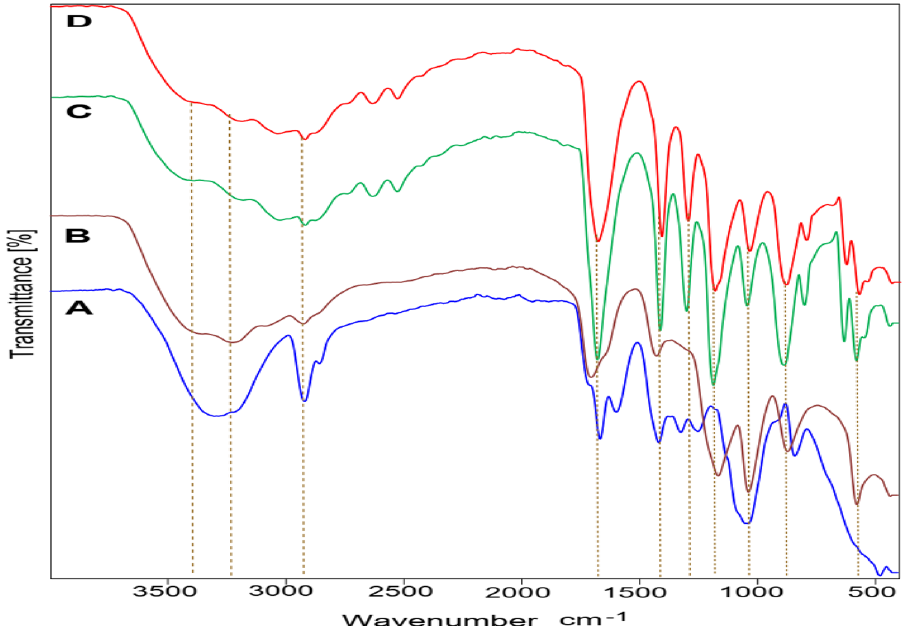
Figure 1. FT-IR spectra of CMC/PVA/AA based hybrid polyelectrolytic membrane ( A ) Virginal CMC/PVA/ AA membrane. ( B ) CMC/PVA/AA-(4%) CSA. ( C ) CMC/PVA/AA -(4%) CSA-(2%) CCNT. ( D ) CMC/PVA/AA -(4%) CSA-(2%) SAC.